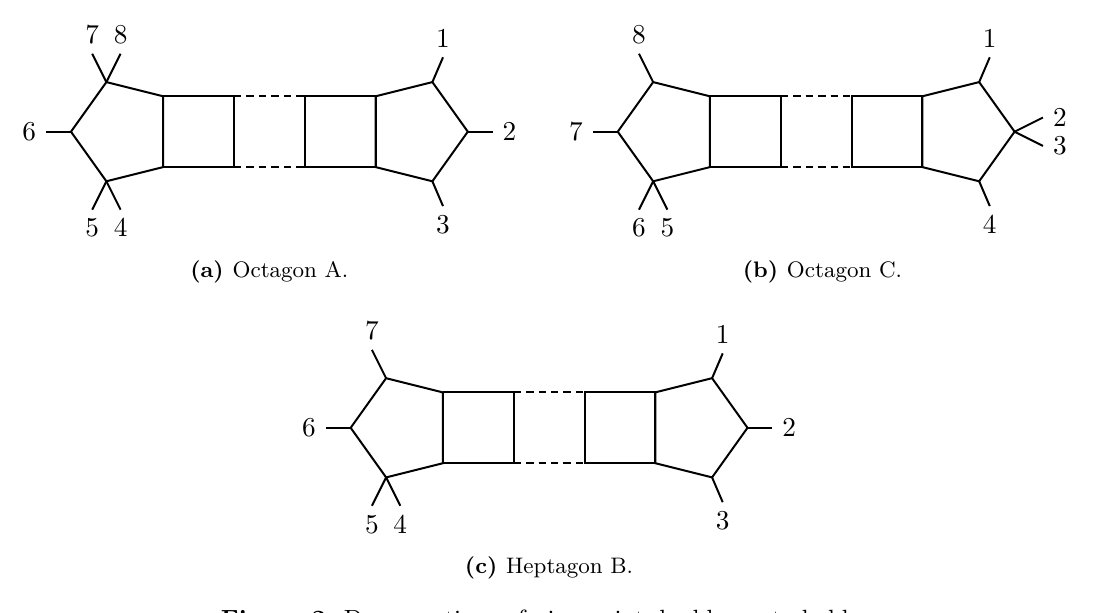
Figure 2 . Degenerations of nine-point